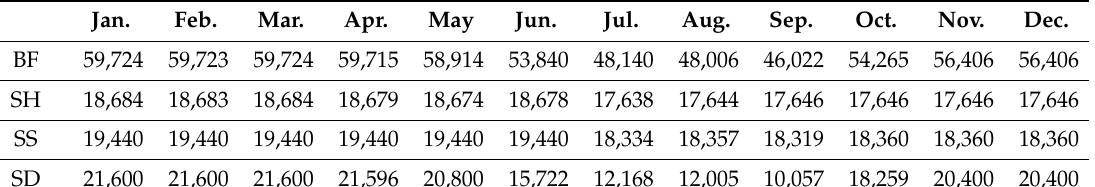
Seasonal number of LAI values (N) from 1 January 2001 to 30 June 2018 for the LDAS-ERA5 configuration.